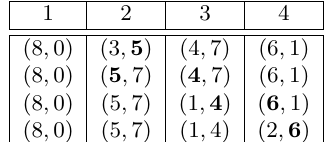
Column i in this table contains the pair ( t i , t i + i ) where t = (8 , 3 , 4 , 6) . Replacing